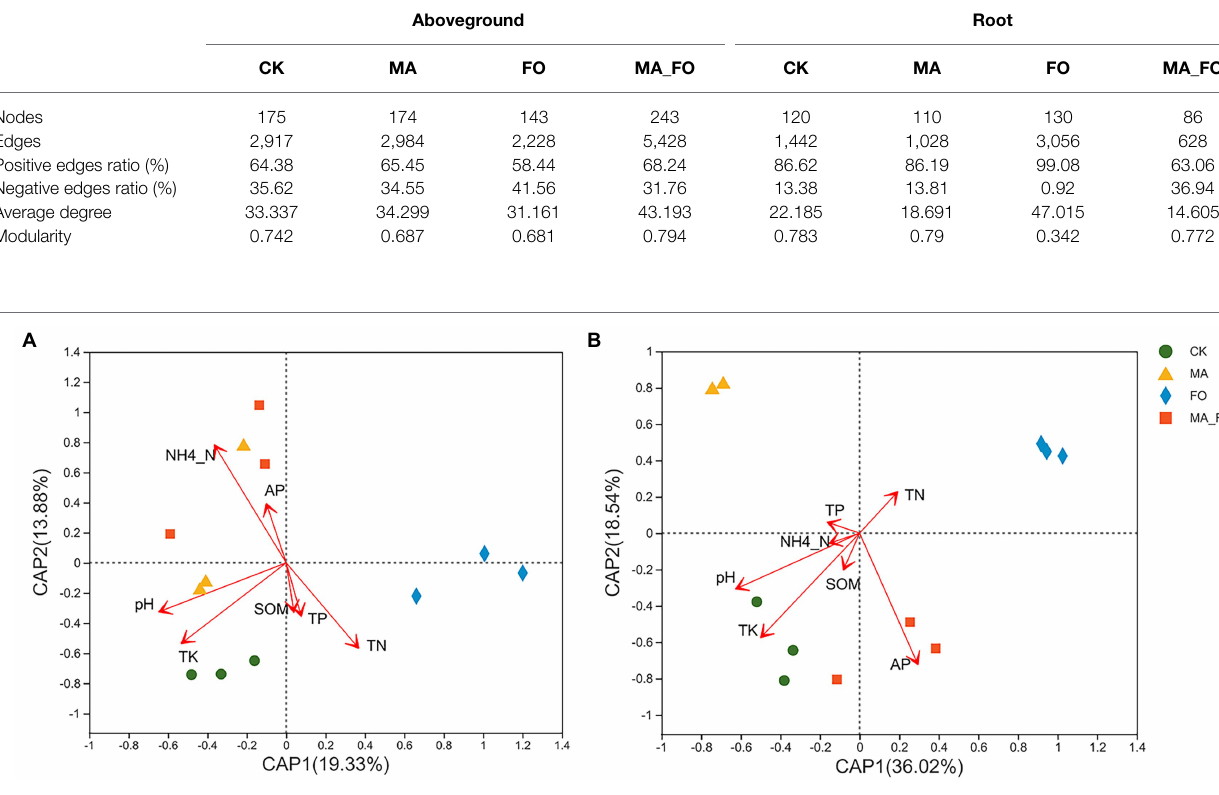
FIGURE 7 | db-RDA analysis of soil microbial community and environmental factors. (A) bacterial community; (B) fungal community. Arrows represent environmental